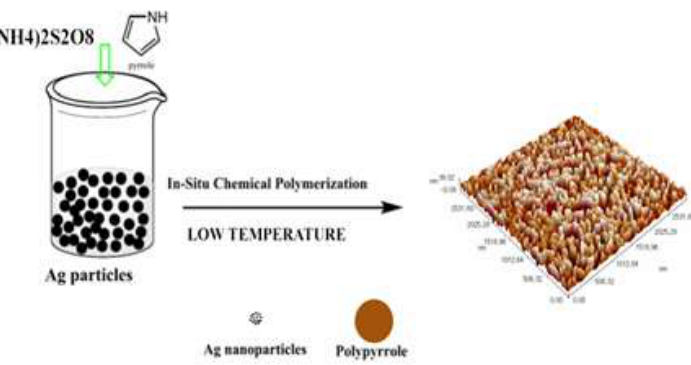
Fig. 2: Schematic representation of formation mechanism of PPy/Ag